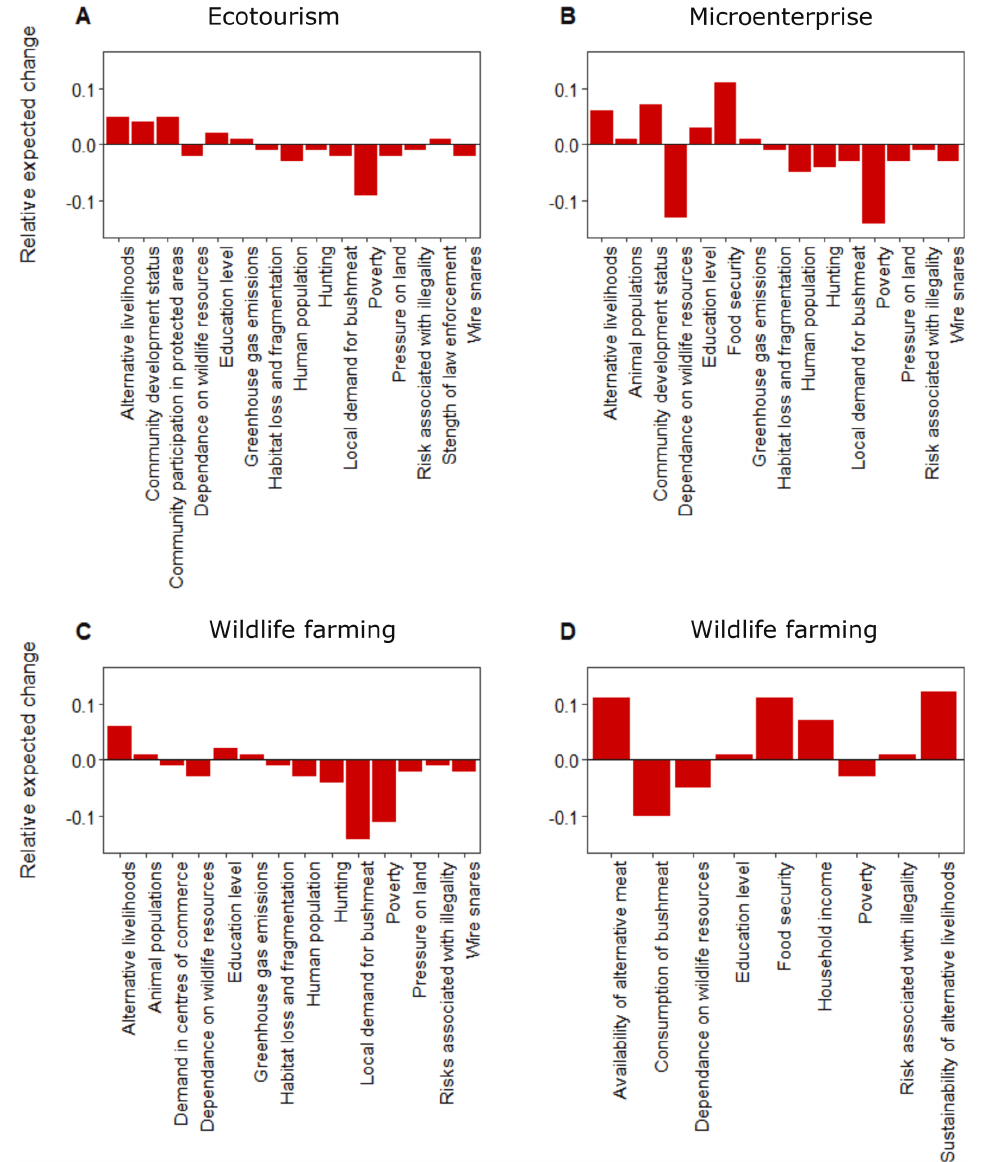
Fig. 4 . Relative expected change to components in the bushmeat hunting fuzzy cognitive map, as a result of (a) an ecotourism program, (b) a microenterprise program, (c) a wildlife farming program, and the relative expected change to components in the bushmeat consumption fuzzy cognitive map as a result of (d) a wildlife farming